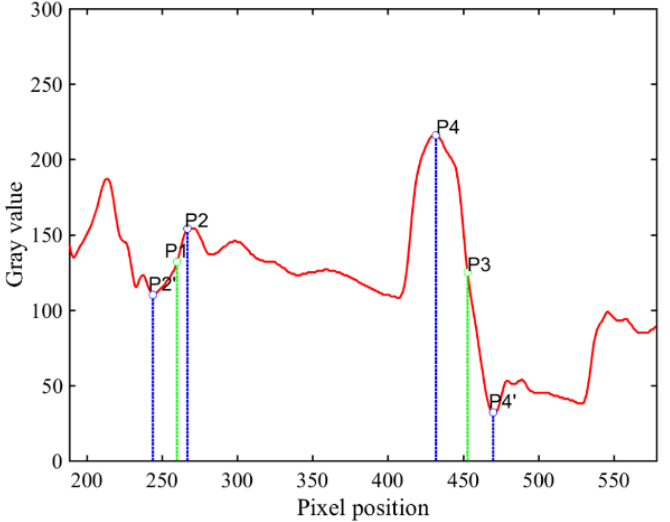
Figure 8. Parrots’ grayscale value change curve.